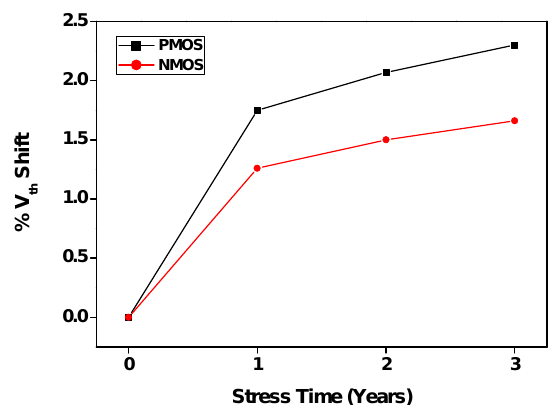
Figure 1. Threshold voltage degradation (in percent of initial threshold voltage) for the PMOS/negative bias temperature instabilities (NBTI) and NMOS/ positive bias temperature instabilities (PBTI) case as predicted by the HSPICE for a 32 nm technology node considering DC stress. The rate of threshold voltage degradation is high for the initial years and tends to saturate over time.